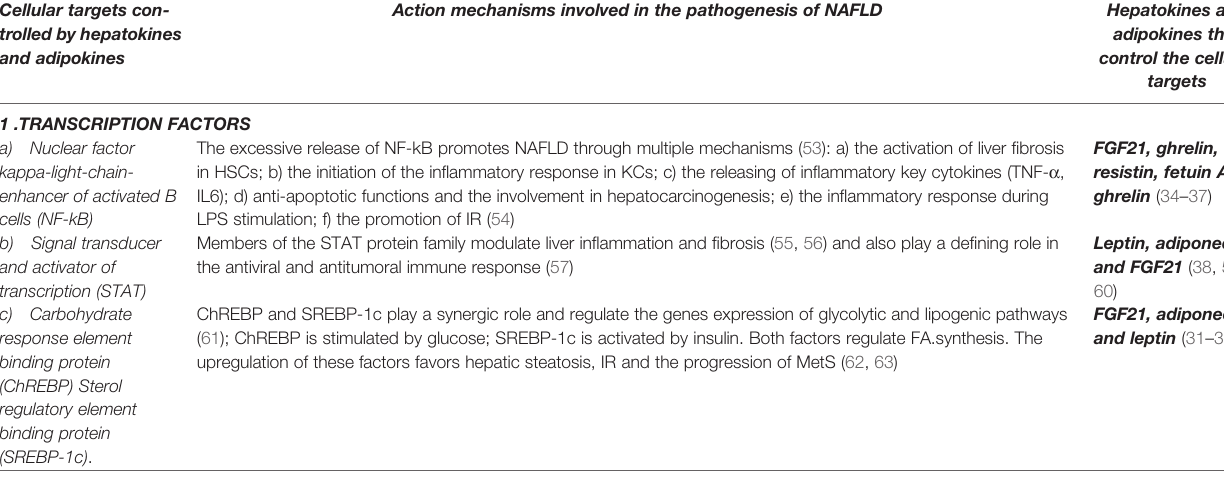
TABLE 1 | Cellular targets regulated by adipokines and hepatokines with relevance in the pathogenesis of non-alcoholic fatty liver disease and metabolic syndrome. Cellular targets con- trolled by hepatokines and